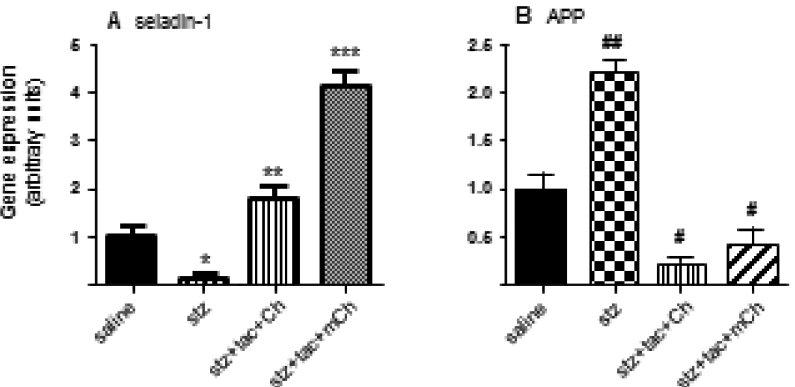
Figure 2. Effect of treatment on seladin-1 (A) and APP (B) expression analyzed by real-time PCR. Stz application reduced seladin-1 significantly (p≤0.05). This effect was counteracted by the co-application of tac-loaded chitosan. The use of magnetic chitosan further boosted tac effects. Stz application increased APP expression. Here, both non-magnetic and magnetic chitosan plus tac completely prevented this effect and further reduced APP levels significantly vs the saline group. *p≤0.05 stz vs saline, **p≤0.005 stz+tac+Ch vs stz or vs. saline, ***p≤0.0001 stz+tac+mCh vs stz or vs. saline, #p≤0.001 stz+tac+Ch/stz+tac+mCh vs stz, ##p≤0.05 stz vs saline. Data for saline treatment were set to